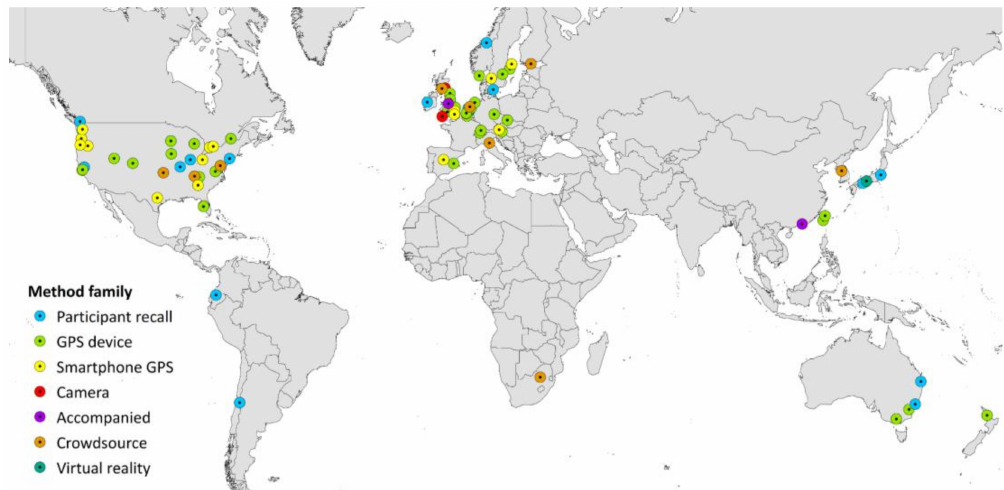
Figure 5. Geographical spread of the empirical research (112) by location of data